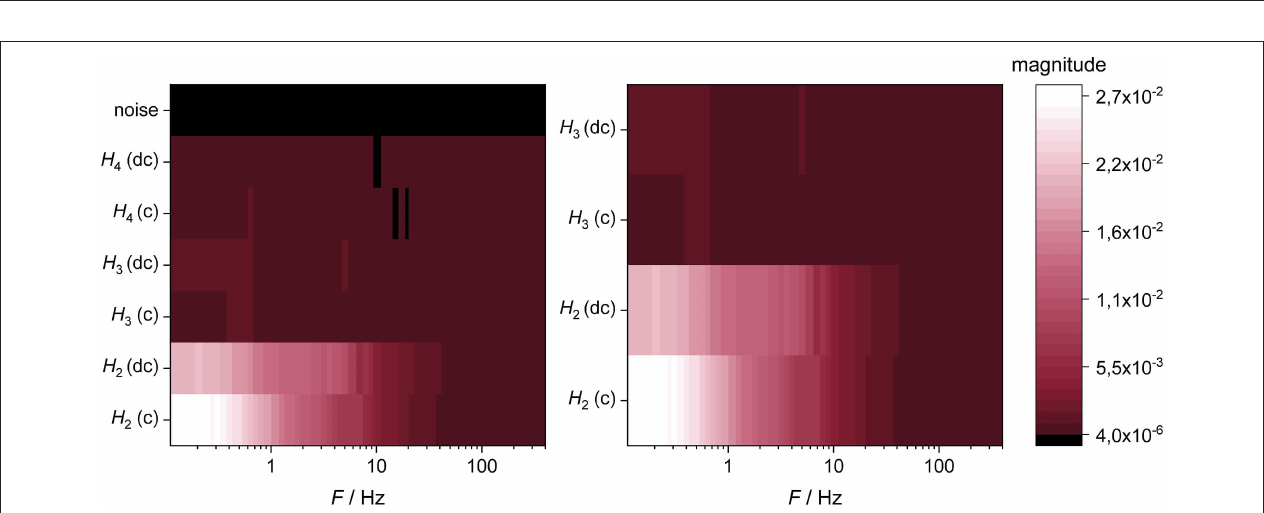
FIGURE 10 | Higher harmonics (H2–H4) in charge (c) and discharge direction (dc) and the corresponding random noise of the measurement setup at a cell voltage of 3.7V at a temperature of 0 ◦ C (Left) and the corresponding magnification (Right) .